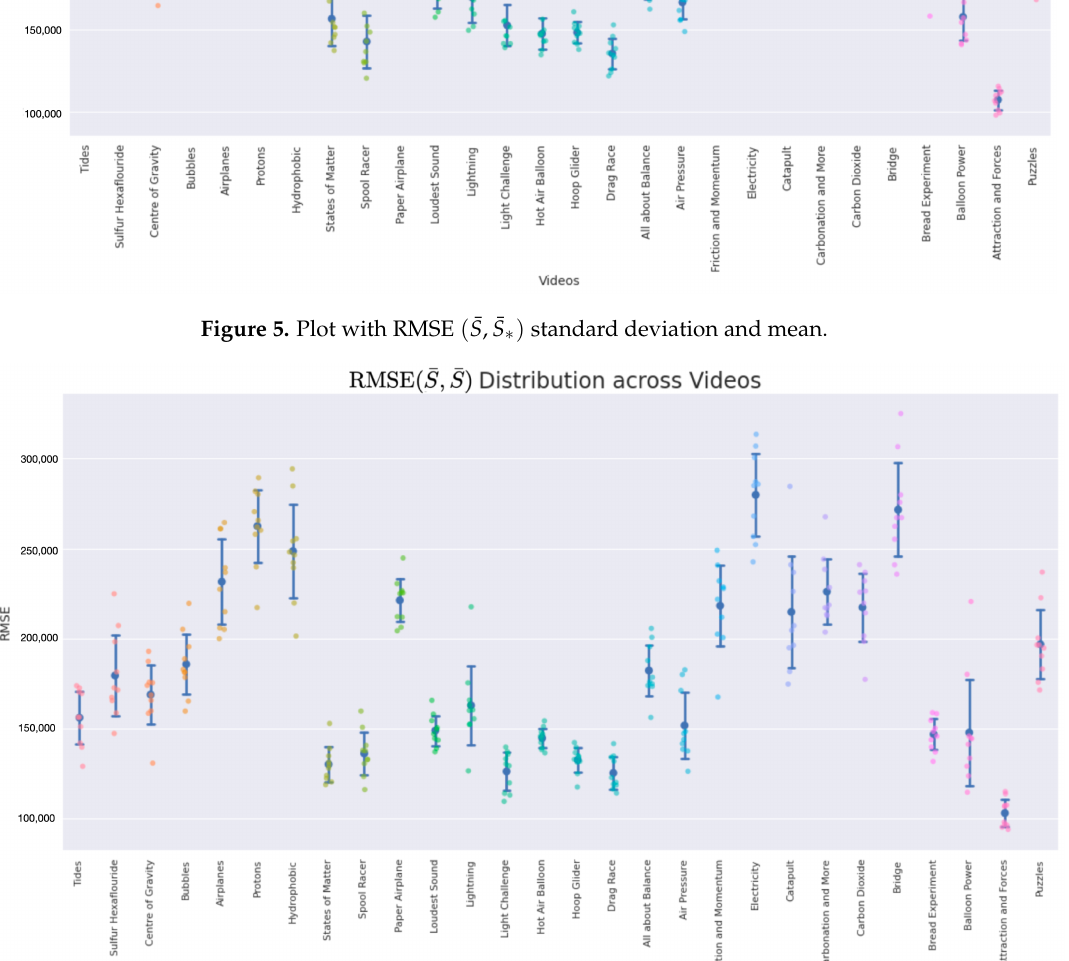
Figure 6. Plot with RMSE ( ¯ S , ¯ S ) standard deviation and